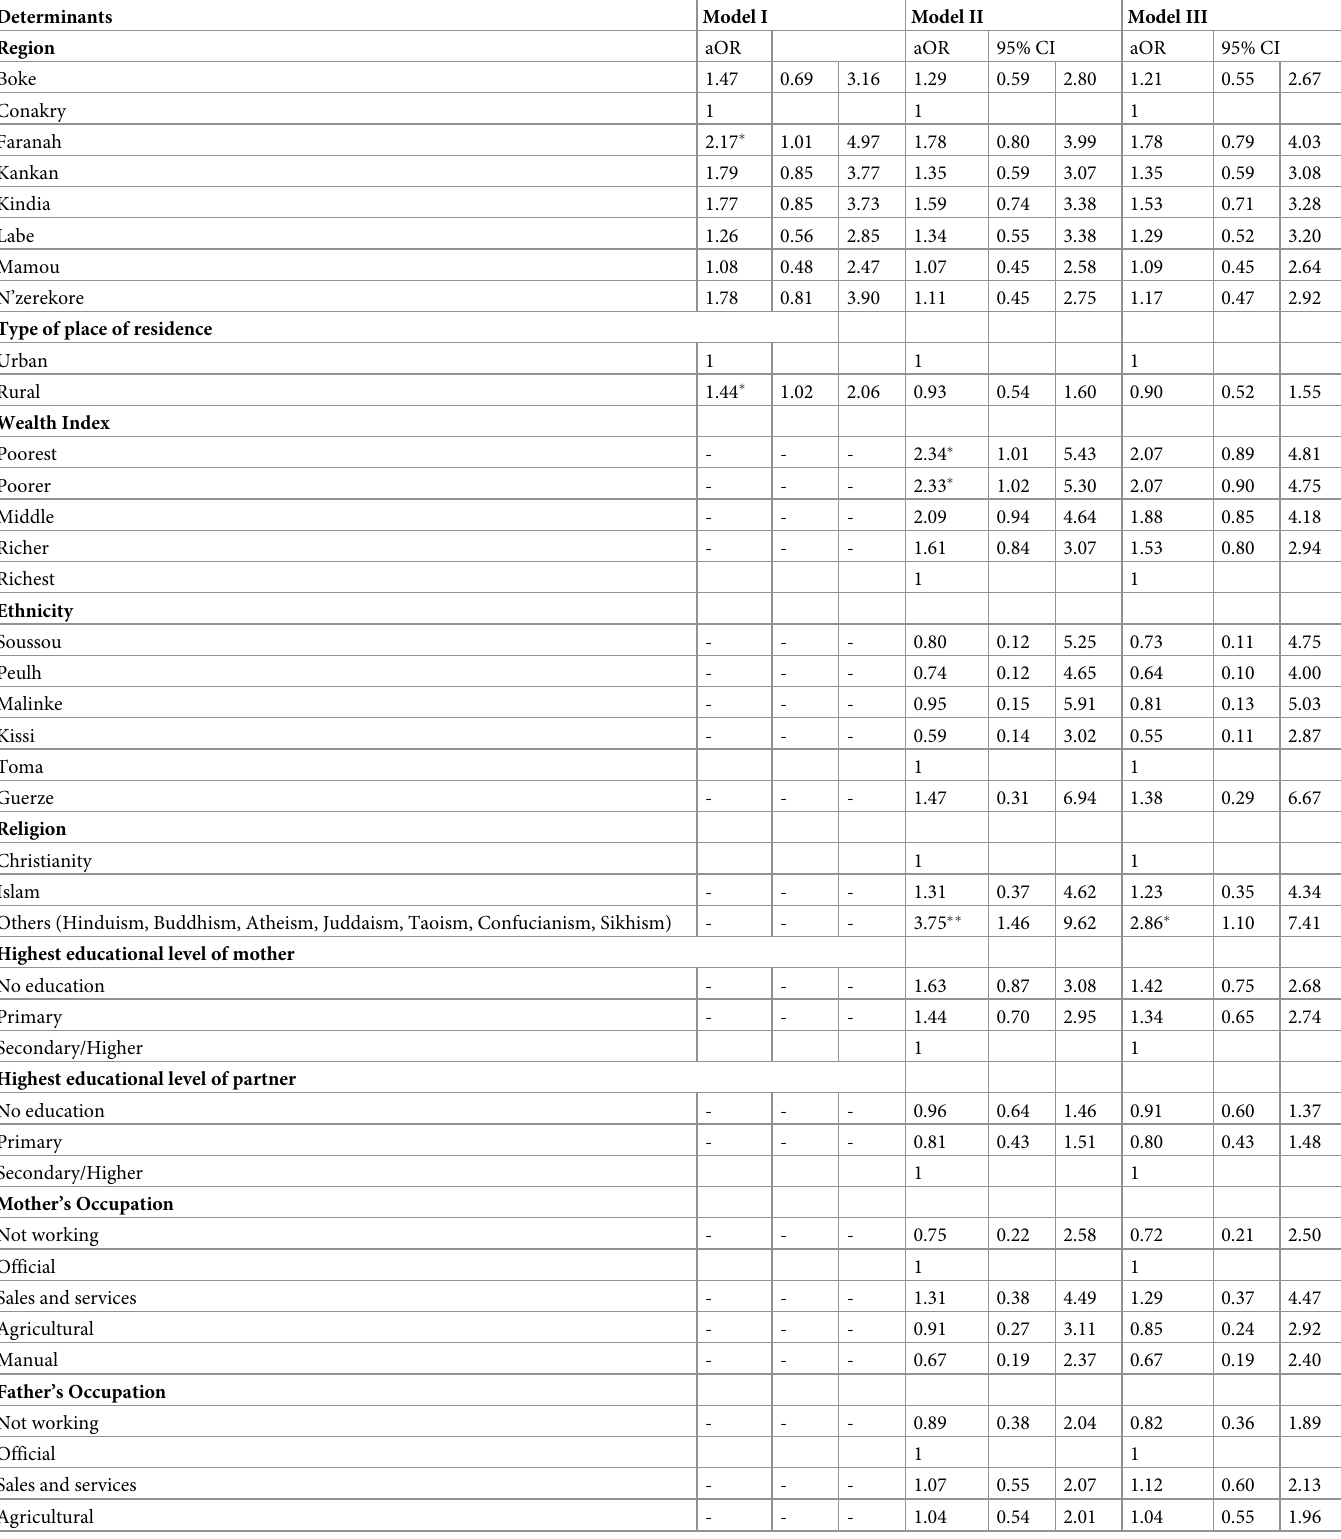
Table 2. Multivariate hierarchical logistic regression results by determinants for under-five mortality -adjusted odds ratio.